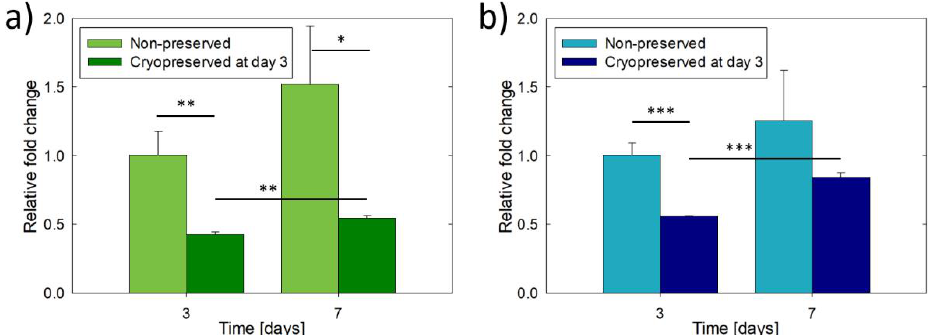
Figure 2. Cell metabolic activity of 3D-bioprinted osteoblast constructs with or without cryopreservation after 3 days of culture: ( a ) MG-63 constructs and ( b ) Saos-2 constructs. The results are expressed as relative fold change compared to the cell metabolic activity obtained on day 3 without cryopreservation. Asterisks indicate statistically significant differences at * p < 0.05, ** p < 0.01, *** p < 0.001, n = 3.